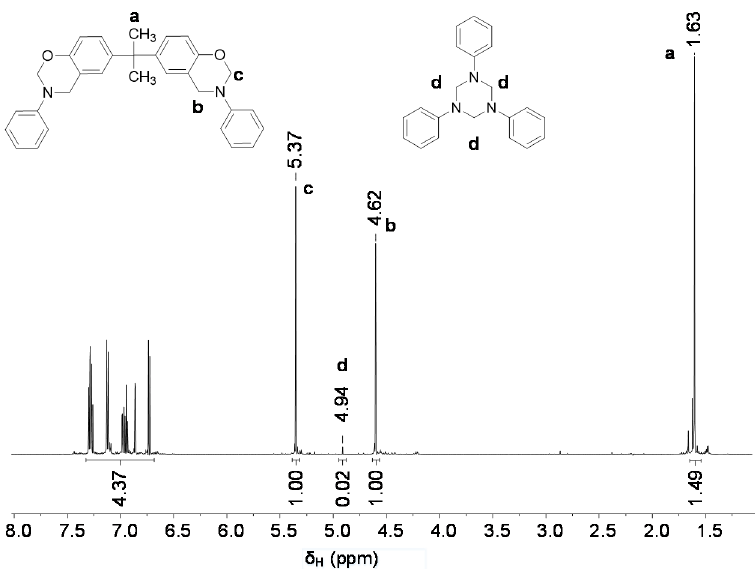
Figure 1. 1 H NMR spectrum of BA-a benzoxazine synthesized according to Scheme 1.